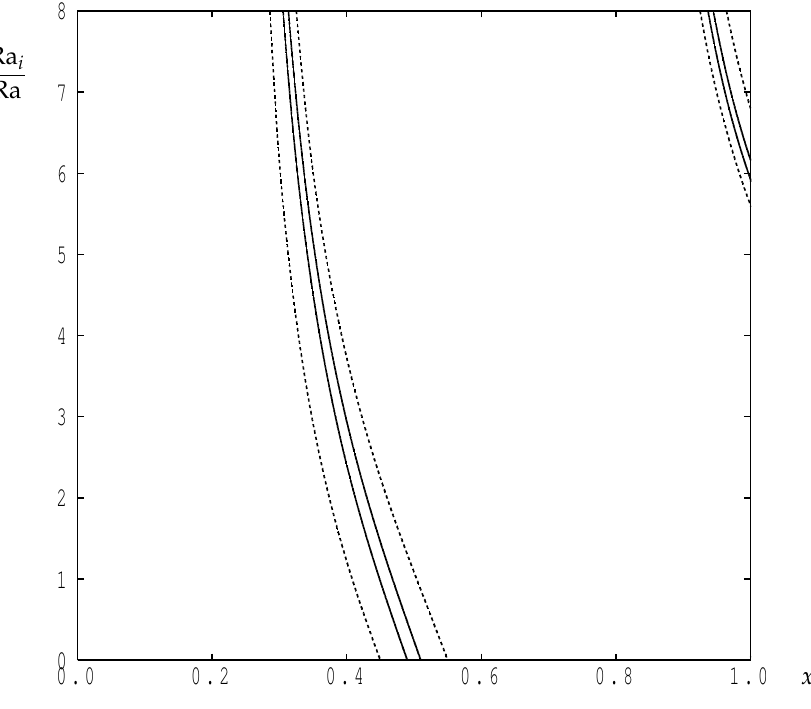
= 0.01 (continuous i /Ra when Rb/Ra